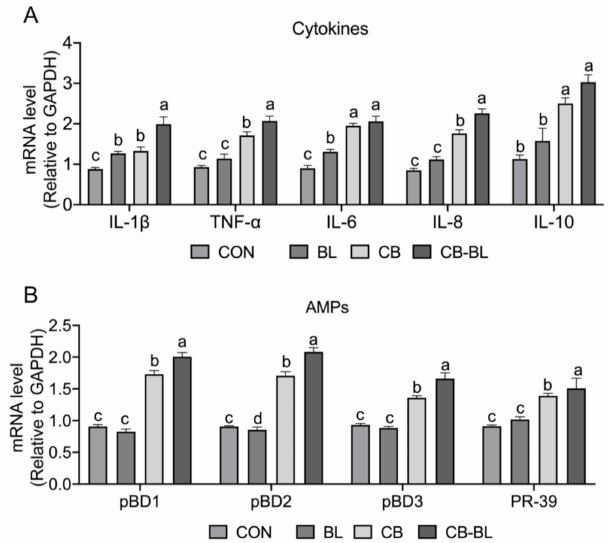
Figure 3. Effects of C. butyricum ZJU-F1 on intestinal immune response. ( A ) qRT-PCR quantified mRNA abundance of cytokines, including IL-1 β , TNF- α , IL-6, IL-8 , and IL-10 , in jejunum of piglets fed each diet. ( B ) The mRNA level of antimicrobial peptides, including pBD1, pBD2, pBD3, and PR-39 from the same sample of ( A ). The results were presented relative to those of Gapdh. The data are expressed as the mean ± SEM, n = 6, biological replicates; bars with different small capital letters are statistically different from one